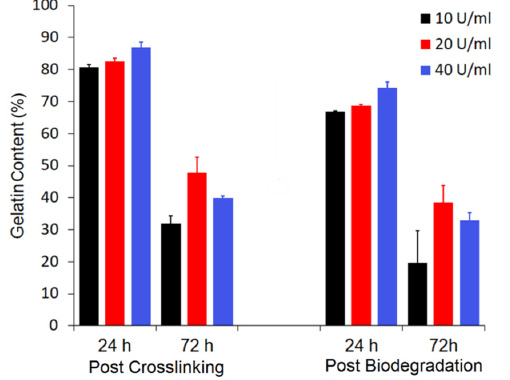
Figure 4. Gelatin content for samples crosslinked with transglutaminase, both after reaction and biodegradation test.